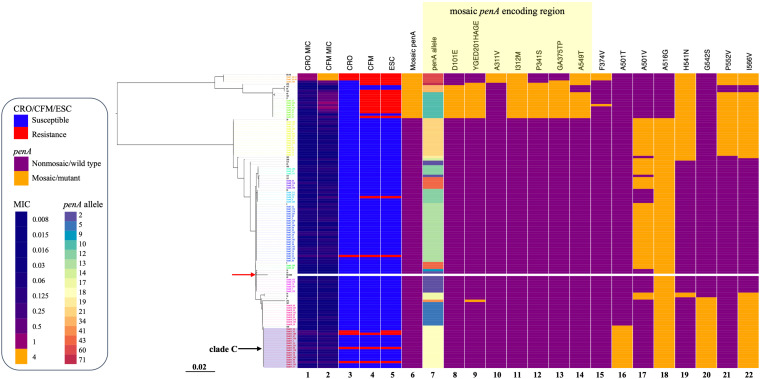
penA gene phylogeny, patterns of antimicrobial resistance, and genetic polymorphisms of 124 N. gonorrhoeae isolates. Left: Phylogenetic reconstruction of 124 isolates based on the penA gene and using the maximum likelihood. The red arrow indicates reference strain FA1090. Heatmap. Columns 1 and 2: MIC values of CRO and CFM. Columns 3–5: Susceptible/resistant categories according to the EUCAST MIC breakpoints of CRO, CFM, and ESCs. Column 6: Any mosaic penA allele. Column 7: penA alleles. Columns 8–22: Non-synonymous amino acid changes from wild type in PenA. The purple rectangle indicates clade C as described in the text. The yellow rectangle indicates substitutions in the mosaic penA coding region. Sequence names are colored by cluster.